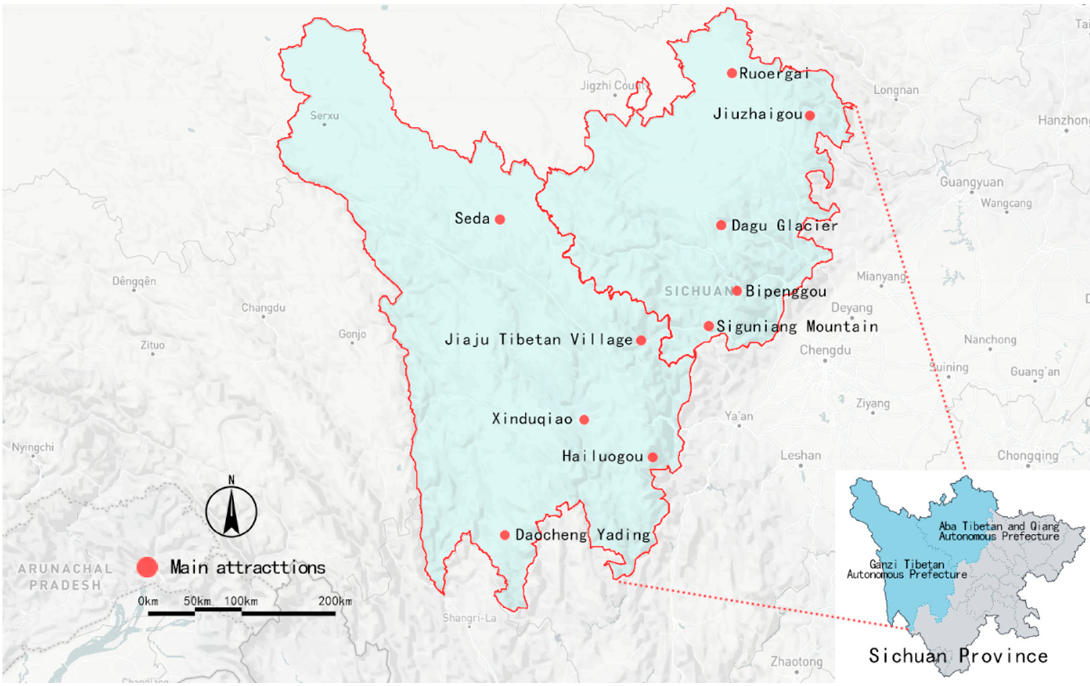
Figure 1. Study attraction locations.